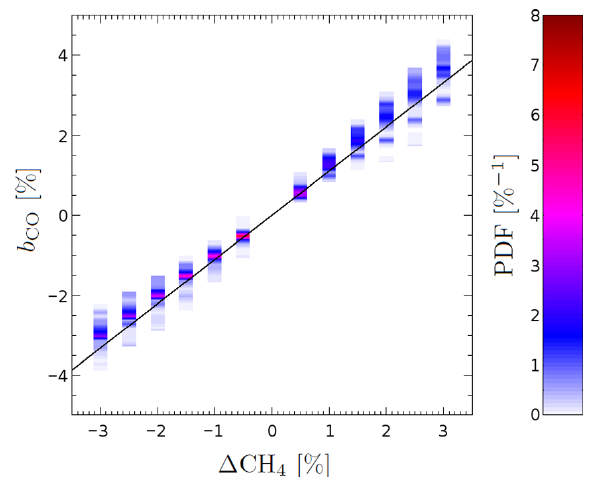
Figure 9. CO bias due to a priori errors in CH 4 for the clear sky measurement ensemble of Fig. 5. For each CH 4 error, the CO bias probability function is shown. The CO error sensitivity is estimated by a linear regression through all data points (solid